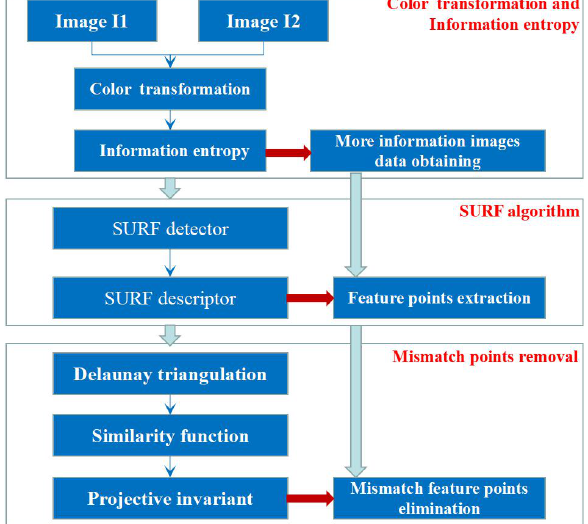
Fig. 1. The overall flowchart of the proposed